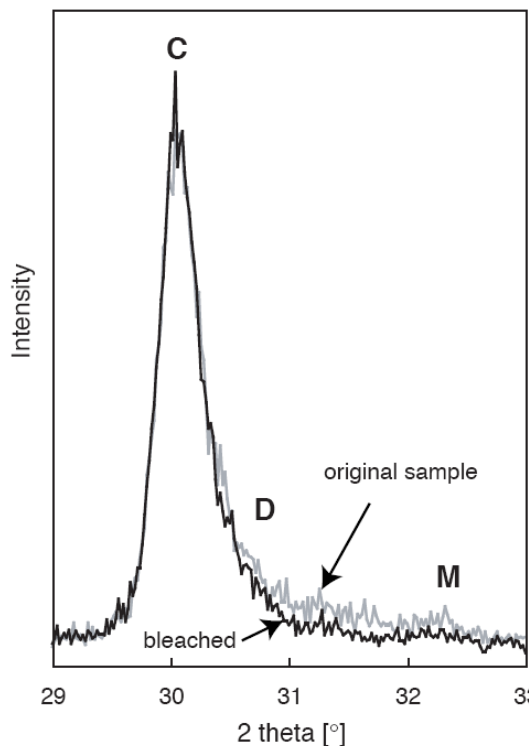
Fig. 9. Comparison of XRD data of an H.onkodes sample before (grey) and after treatment with bleach (black), focusing on the (104) carbonate peak. C, D and M indicate peak positions of calcite, ideal dolomite and magnesite. The decreased intensity between dolomite and magnesite suggests removal of such compositions by bleaching. Sample from Bise, Okinawajima Island, Japan, collected in May 2007 from approximately 5m depth at the reef front, (Kato et al.,